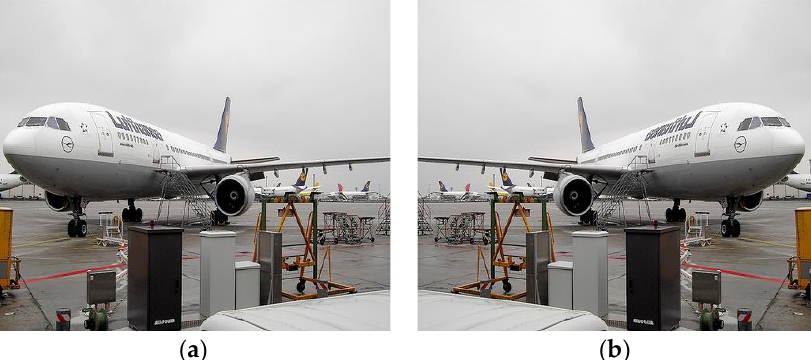
Figure 5. ( a ) Before and ( b ) after the application of the horizontal flipping augmentation technique.